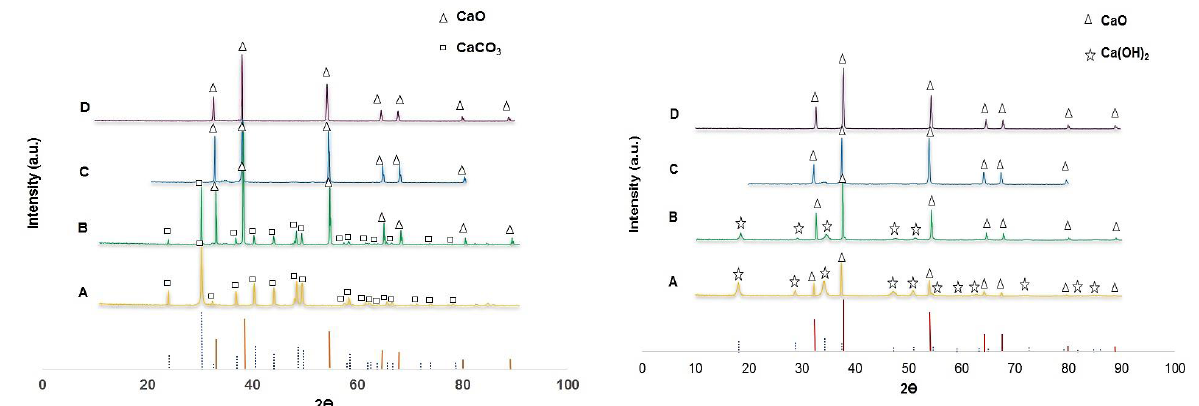
Figure 2 : XRD pattern of samples of Pure CaO (A) Pure CaO before calcination, (B) Pure CaO with 800°C close atmosphere calcination, (C) Pure CaO with 1000°C nitrogen gas flow calcination,(D) Pure CaO with 1000°C open air